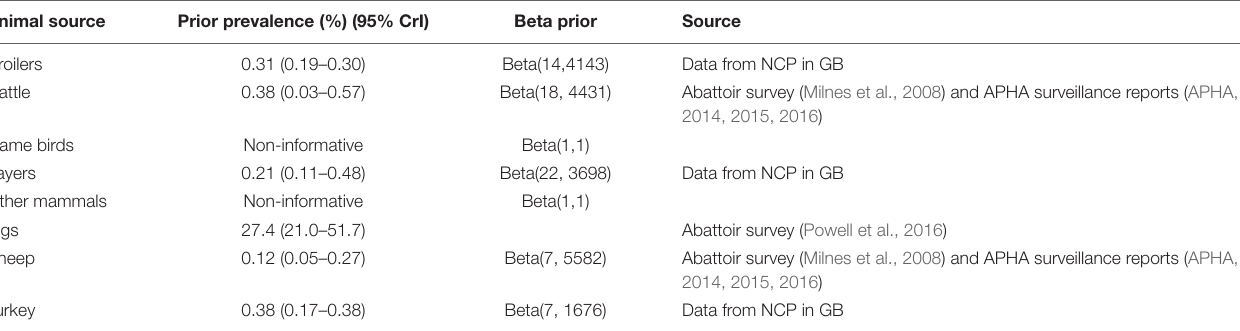
TABLE 1 | Priors used for animal infection prevalence for a Bayesian source attribution model for Salmonella Typhimurium (including monophasic variants) in Great Britain. Animal